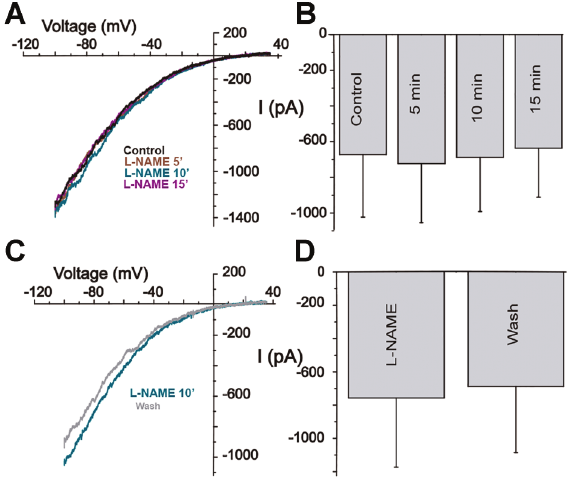
Figure 2. L-NAME did not impair purinergic currents. A , ATP- elicited currents I (cid:2) V plot after treatment with 300 m M L-NAME for 5 (brown), 10 (light green) and 15 (purple) min. C , ATP-elicited currents IxV plot after treatment with 300 m M L-NAME for 10 min (light green) and after 15 min ’ wash (gray). B (n=5 cells) and D (n=5 cells), bar graphs showing the means ± SE of the currents measured at – 70 mV. No signi fi cant changes were observed in the amplitude of the currents. Panel B: P X 0.05, ANOVA and Tukey post-test; panel D: P X 0.05, unpaired t